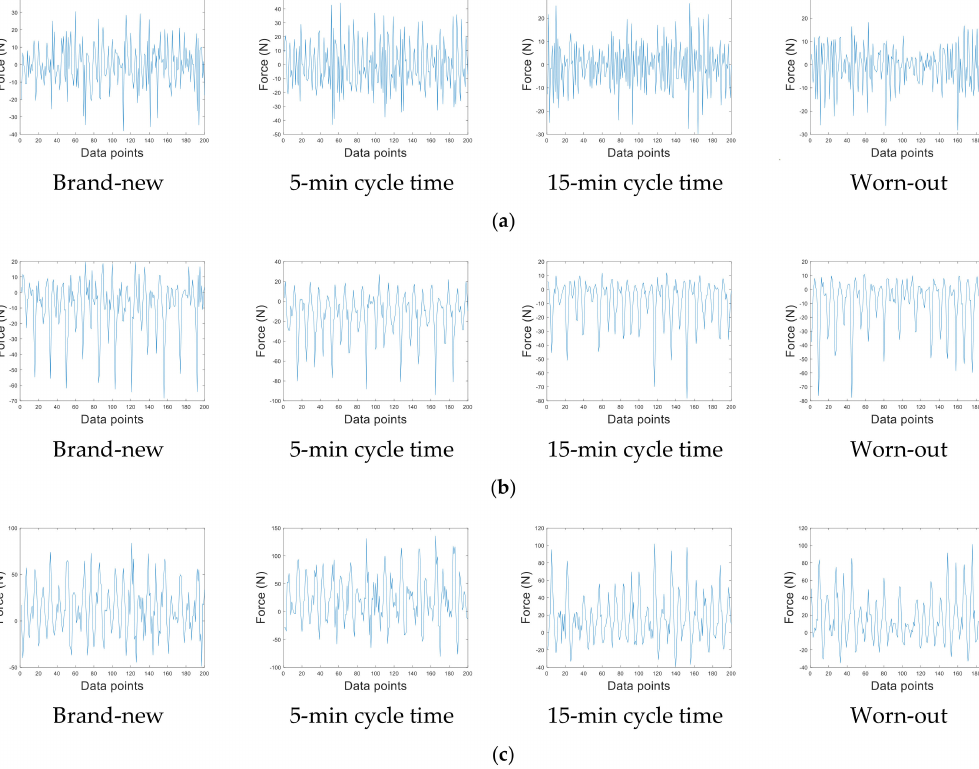
Figure 17. Force signals: ( a ) X-axis, ( b ) Y-axis and ( c )